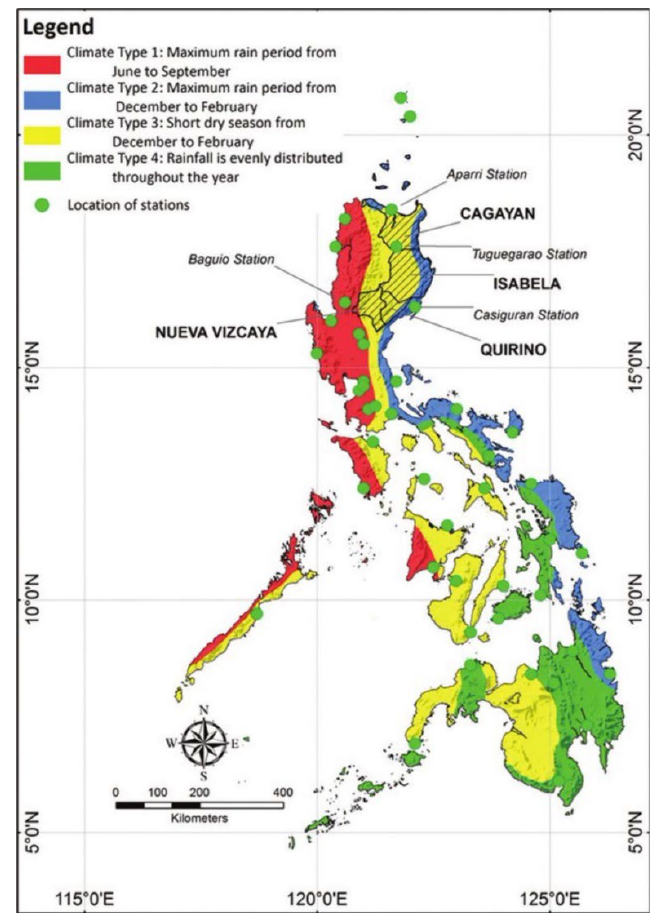
Figure 4. Climate map of the Philippines based on the Modified Coronas Classification (PIDS, 2005) [72].